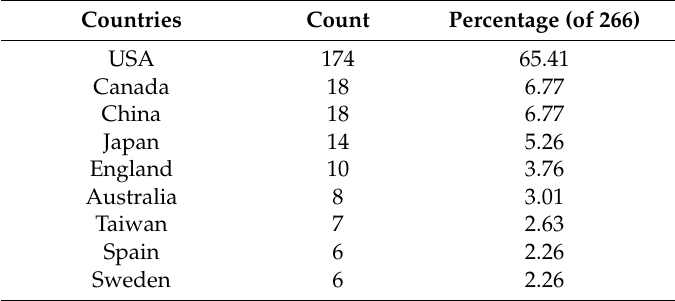
Table 7. Countries publishing SLW publications (more than